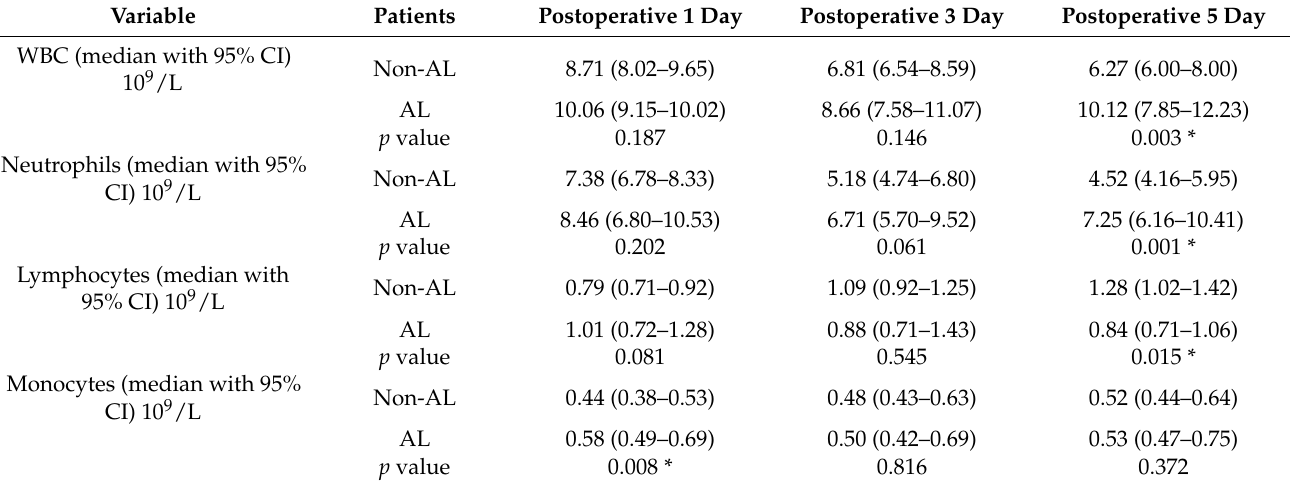
Table 5. Comparison of the mean values of the variables in patients with and without symptomatic AL after propensity score-matched